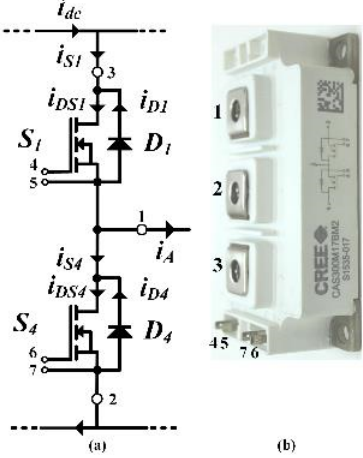
Figure 3. Electrical connection diagram of CAS300M17BM2 SiC power MOSFET module. ( a ) Electrical connection diagram (the two MOSFET chips and their anti-parallel SiC Schottky diodes are labeled as in the first leg of the traction converter in Figure 1); ( b ) the associated all-SiC half-bridge module. (1) Common source/drain point, (2) Source, (3) Drain, (4,6) Gate, (5,7) Kelvin